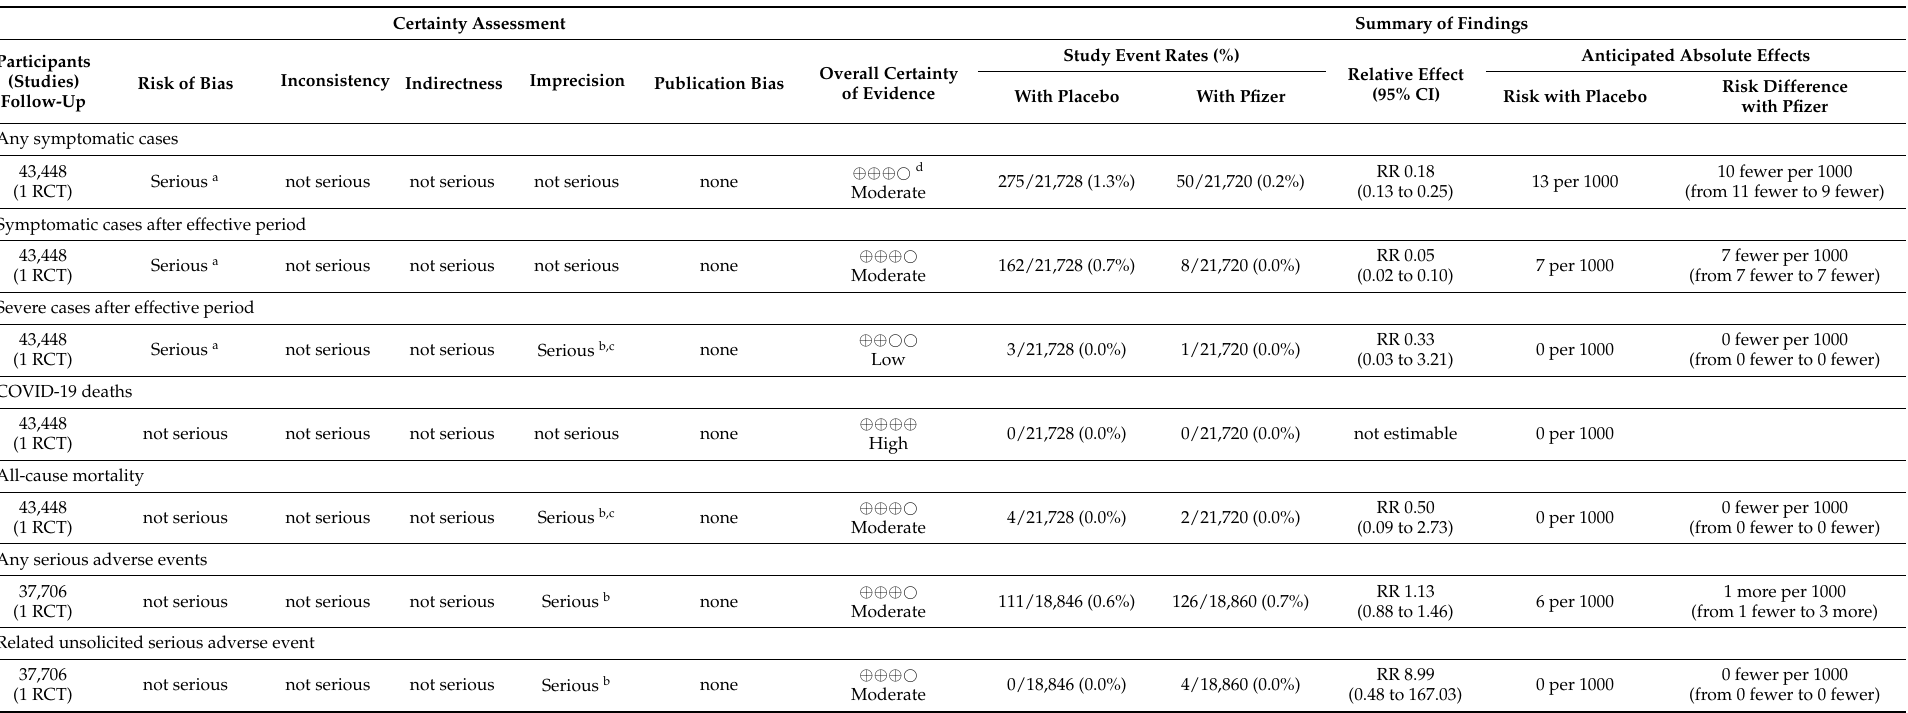
Table 2. GRADE evidence profile denoting the benefits and risks associated with Pfizer vaccine for the prevention of COVID-19 in adults. The table includes relative and absolute effects along with the overall certainty of the